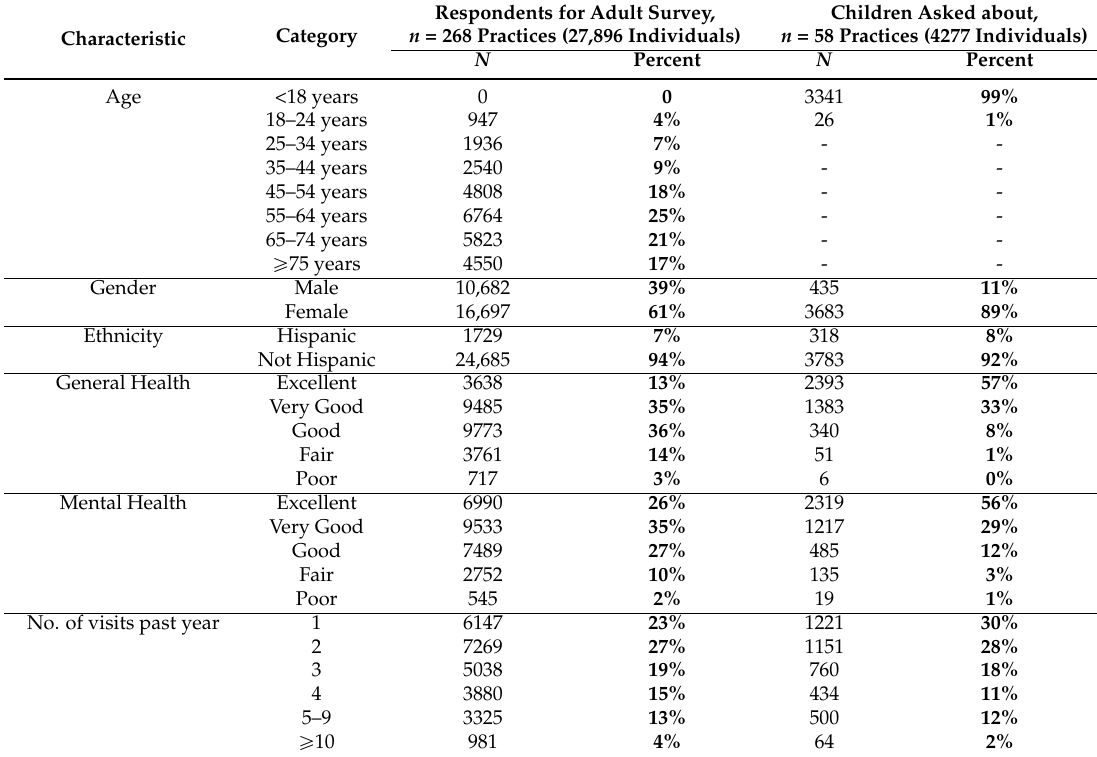
Table 1. Characteristics of adult survey respondents and children who were the patients asked about in child surveys, CAHPS PCMH 1 ,